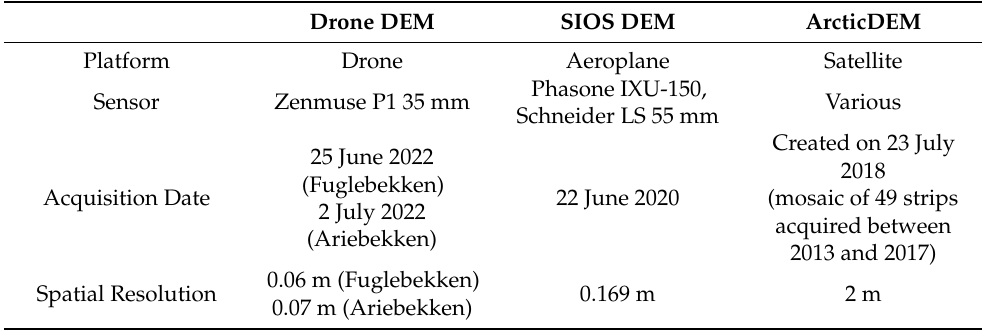
Table 2. Comparison of features of different